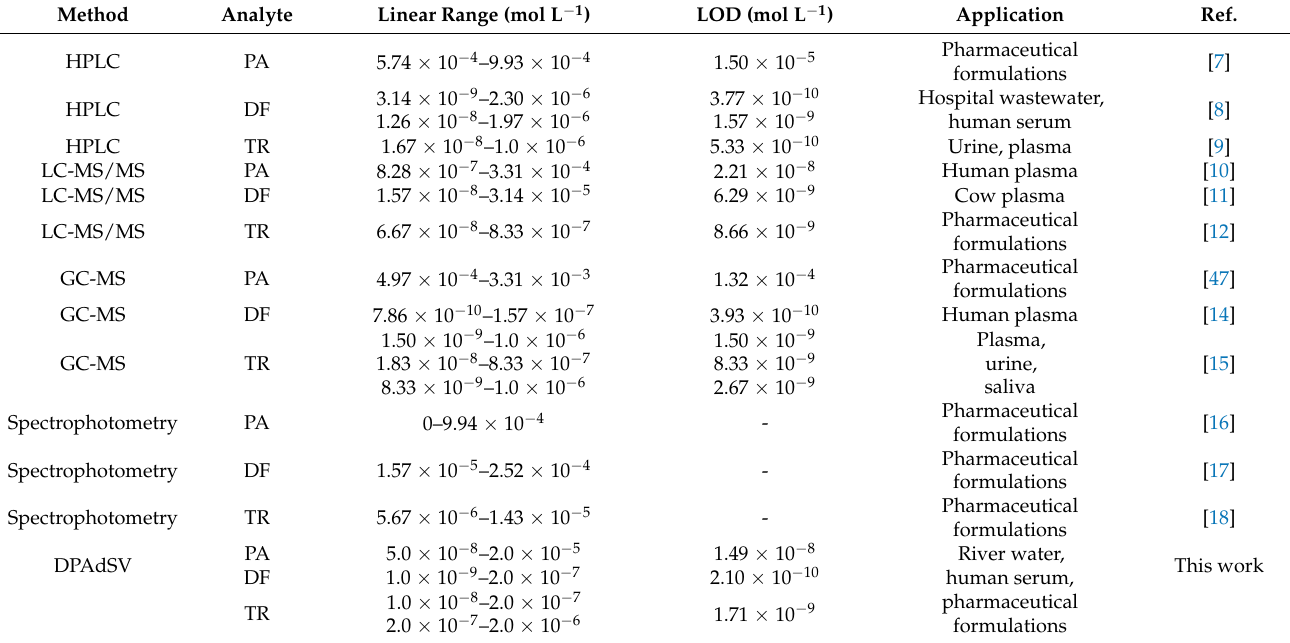
Table 2. Comparison of techniques for analysis of PA, DF, and TR.